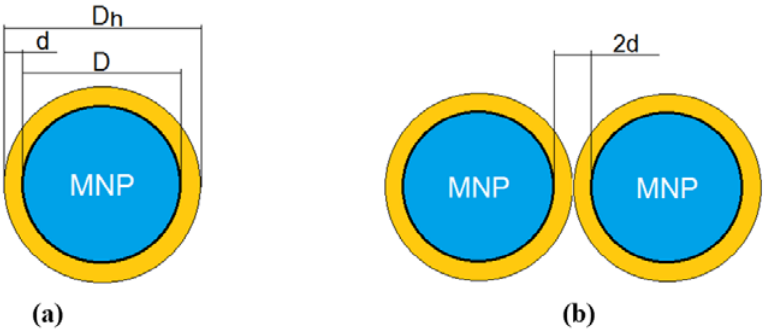
Figure 2. ( a ) The core-shell model of the magnetic Fe 3 O 4 - γ -CDs bionanoparticle: the core is the magnetic Fe 3 O 4 nanoparticle with the diameter D, and the shell is the organic layer from the surface ( γ -CDs with biopolymer) with the thickness d; D h is the hydrodynamic diameter of the bionanoparticle; ( b ) bionanoparticles system with the minimum distance between them 2d for evaluating the maximum interactions.